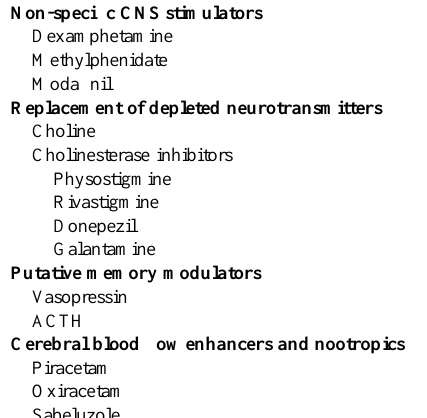
Table 1 Classification of psychostimulants and cognitive en- hancers discussed in the